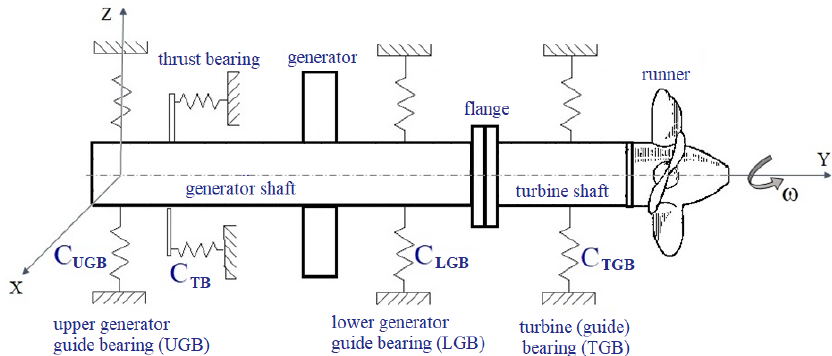
Figure 1. Vertical three-point HU structural design (image turned for ease of presentation).